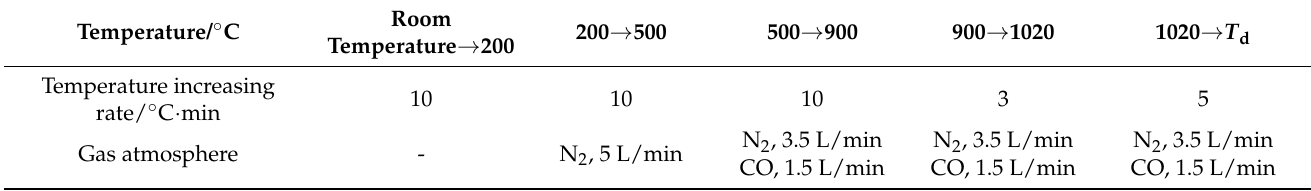
Table 6. Experimental conditions for softening-melting-dripping properties.